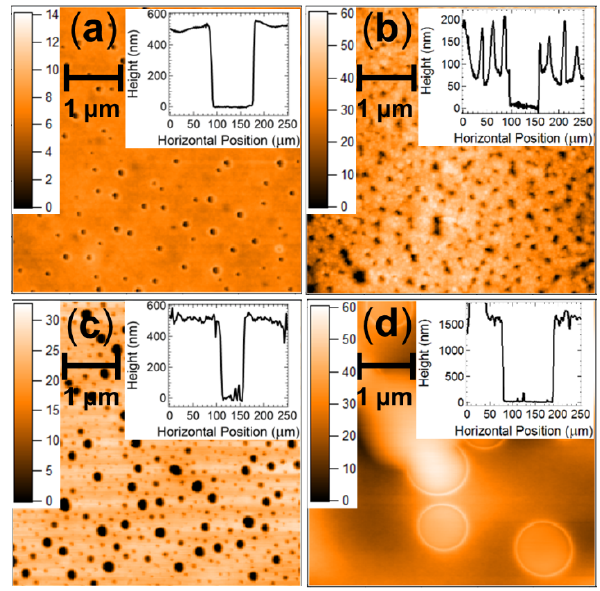
Figure 5. AFM data measured across a size scale of 5 × 5 µm for ( a ) spin-coated PVP films, ( b ) inkjet- printed ZnO films, ( c ) an inkjet-printed PVP wetting layer deposited from 2-propanol, and ( d ) an inkjet-printed PVP dielectric films deposited onto the inkjet-printed PVP wetting layer. The inset show profilometry data for the surface of each film with a step indicating the total film thickness.